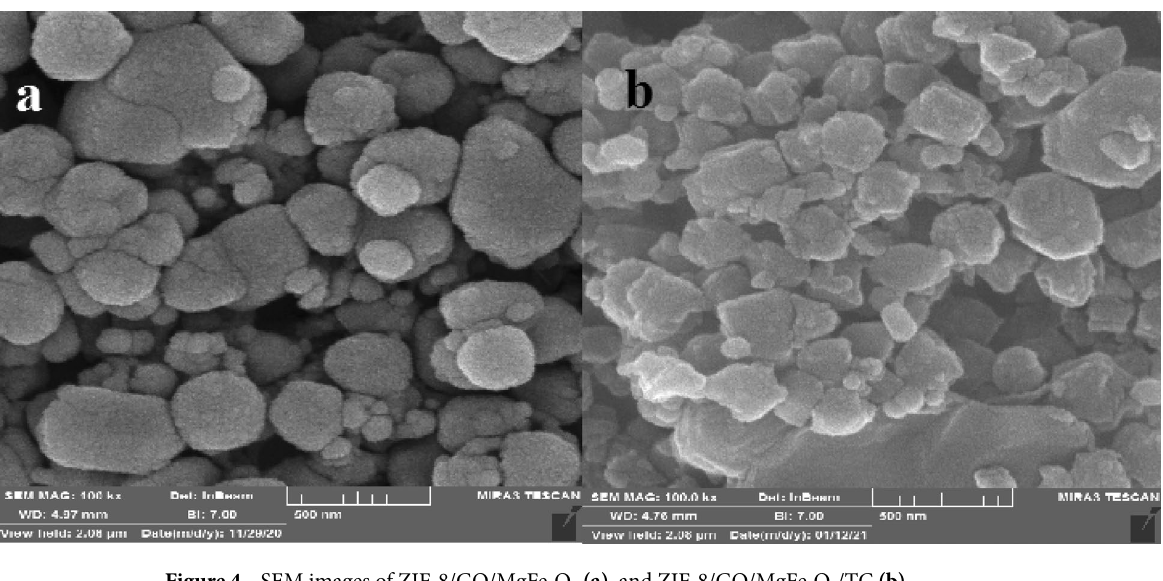
Figure 4. SEM images of ZIF-8/GO/MgFe 2 O 4 (a) , and ZIF-8/GO/MgFe 2 O 4 /TC (b)